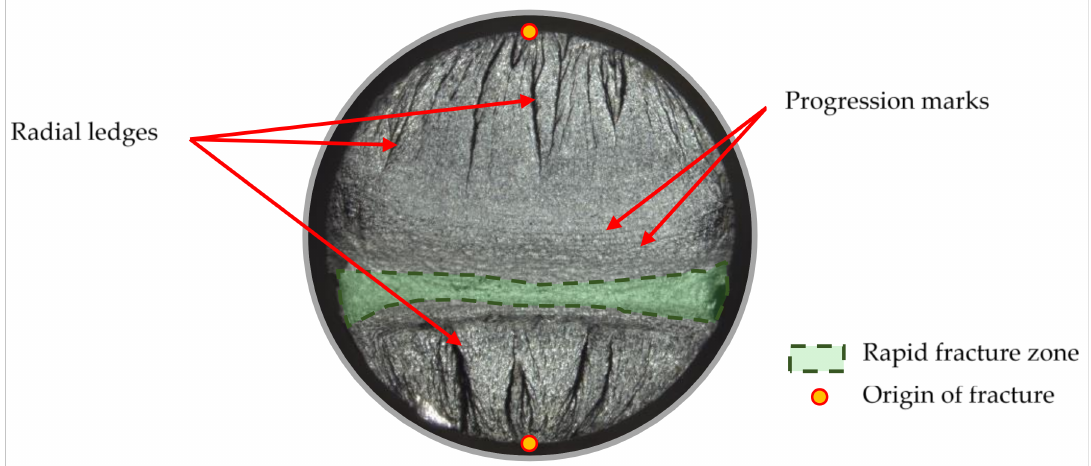
Figure 14. Fatigue fracture with characteristic parts of the crack. Table 8. Presentation of fatigue fractures for the same test duration and different kurtosis values.